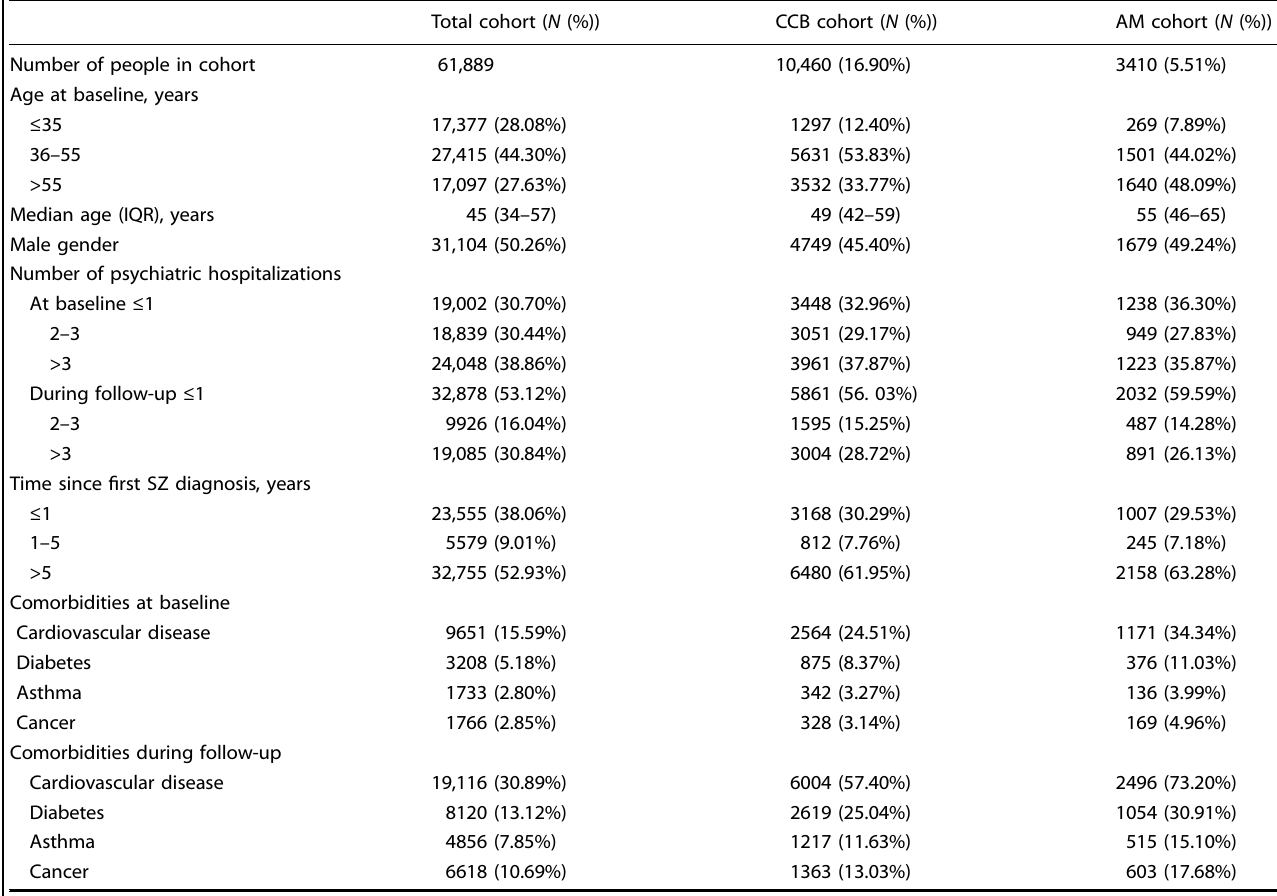
Table 1. Characteristics of the study